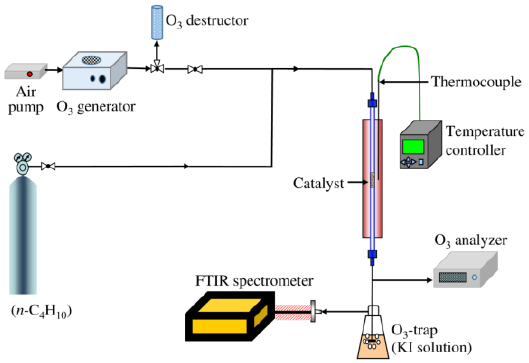
Figure 7. Scheme of the experimental setup.